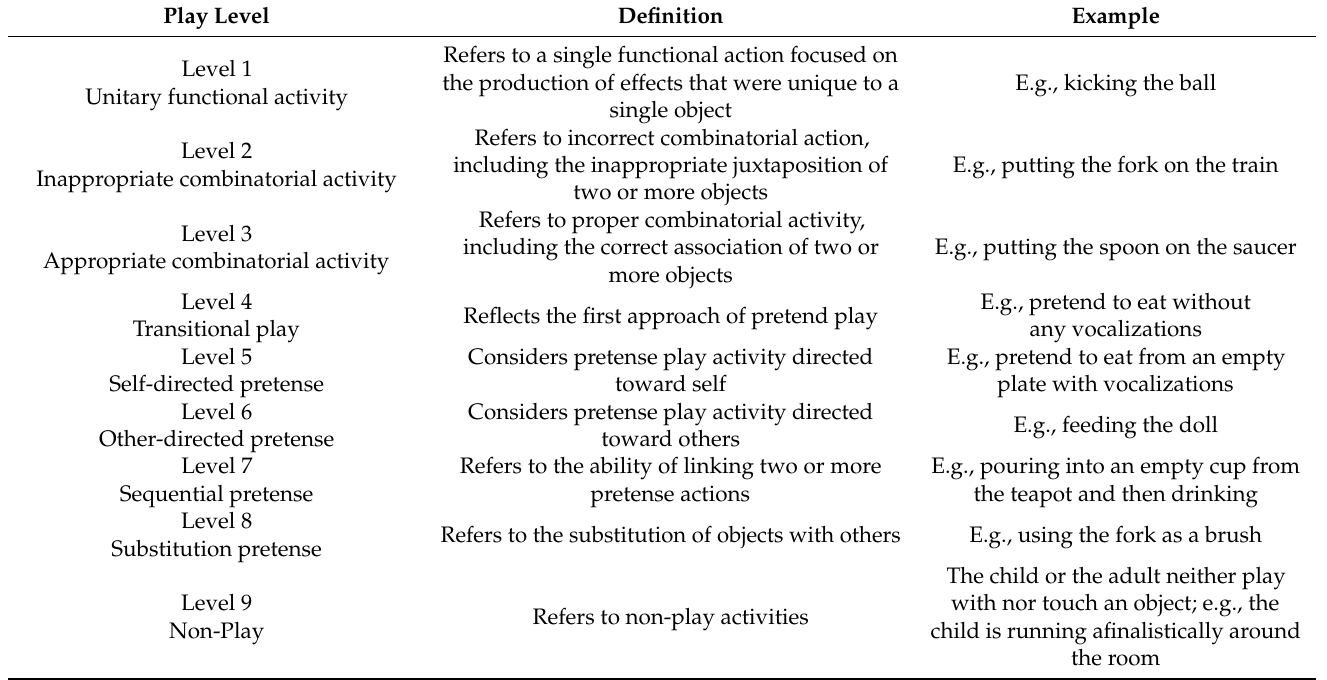
Table 1. Descriptions of play